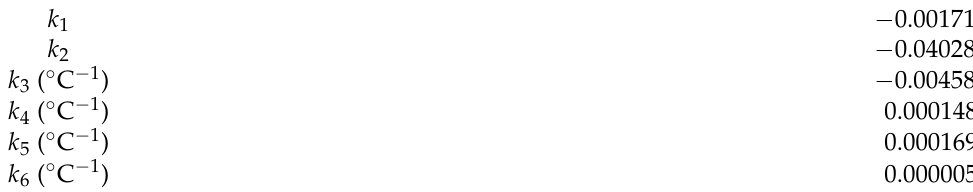
Table 1. Empirical values to be used in Equation (9) for C-Si photovoltaic